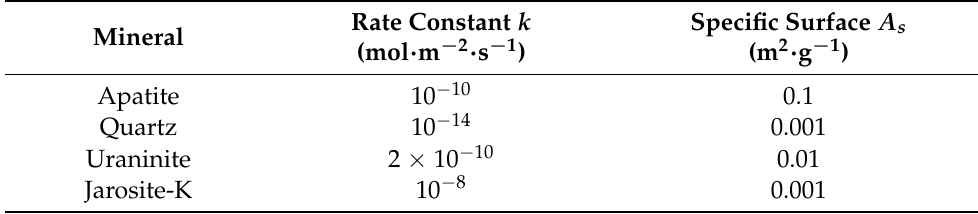
Table 3. Kinetic parameters of considered mineral